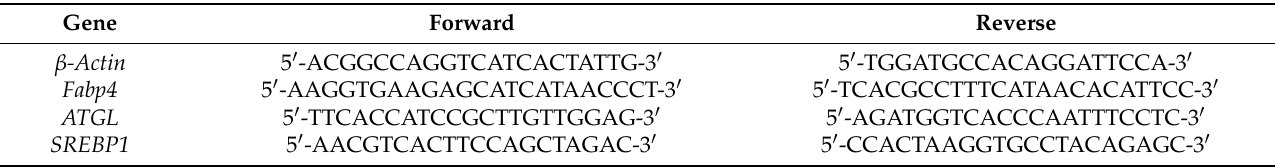
Table 1. Sequences of primers used for